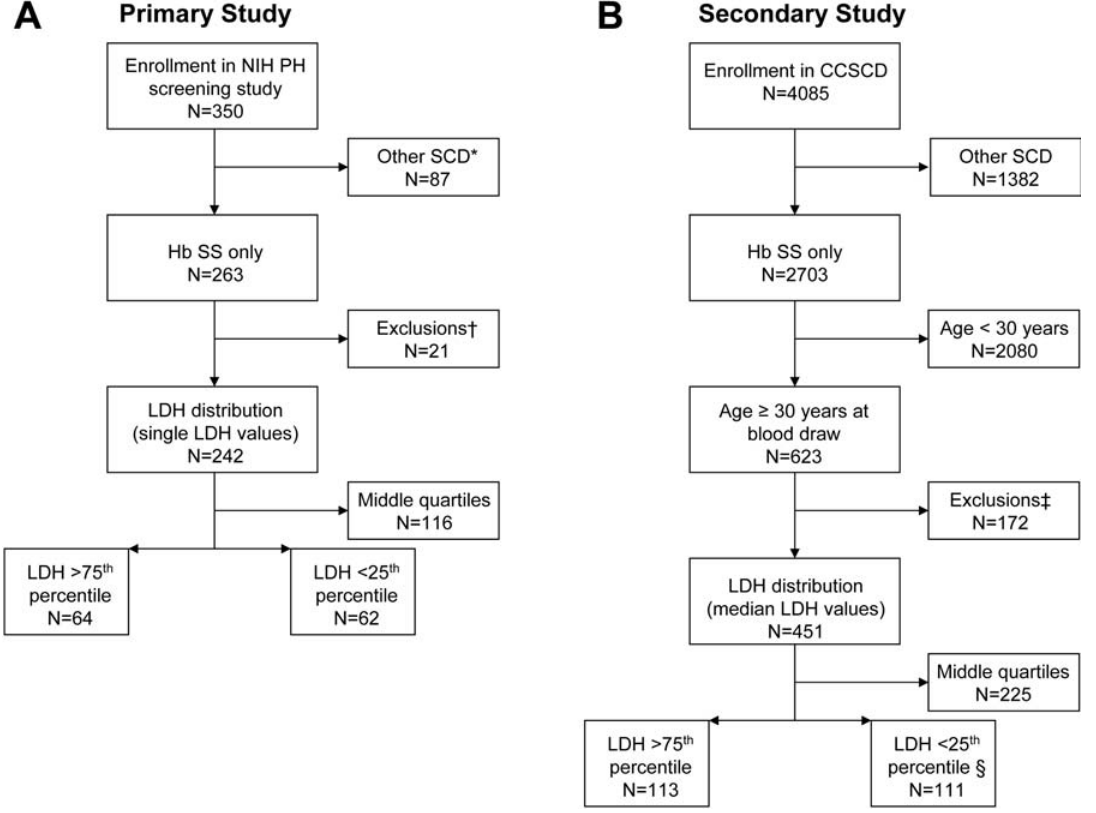
Figure 1. Selection of adult sickle cell anemia subjects for LDH analysis. Panel A: Selection process in the NIH study that identified subjects with the highest and lowest LDH values. * Includes both sickle cell disease cases and 10 subjects for whom no DNA sample was collected. { Of the 21 subjects excluded from analysis, 14 had an excessive hemolysis index for LDH, 2 had no labs drawn, 4 had ALT values greater than 80 IU/L, and 1 had aplastic anemia. Panel B: Selection in the validation study from the CSSCD. { 172 had ALT values greater than 80 IU/L. 1 Two were excluded with unexpectedly low LDH values.